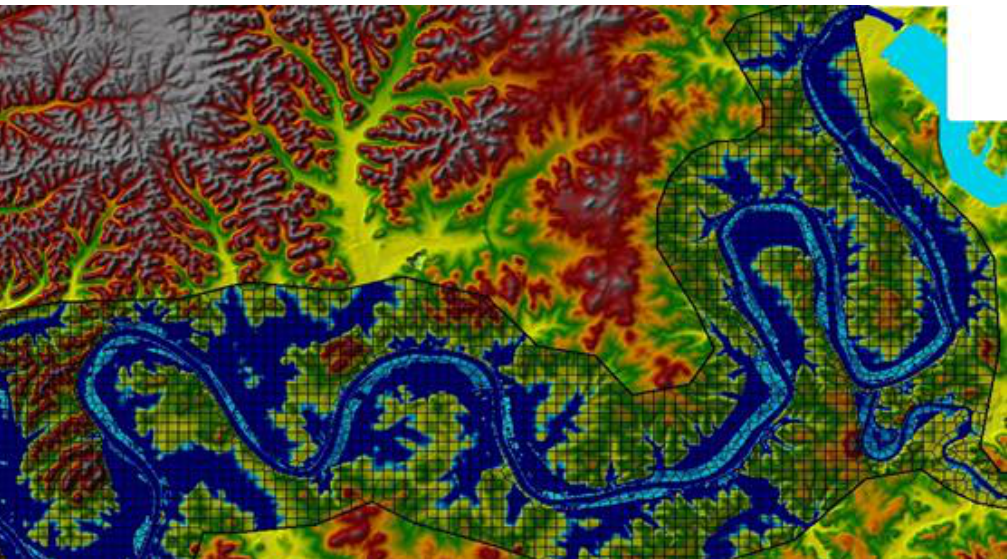
Figure 9. Simulated flooding (inundation areas in blue) Using the HEC-RAS two-dimensional approach for the May 2010 flood event.